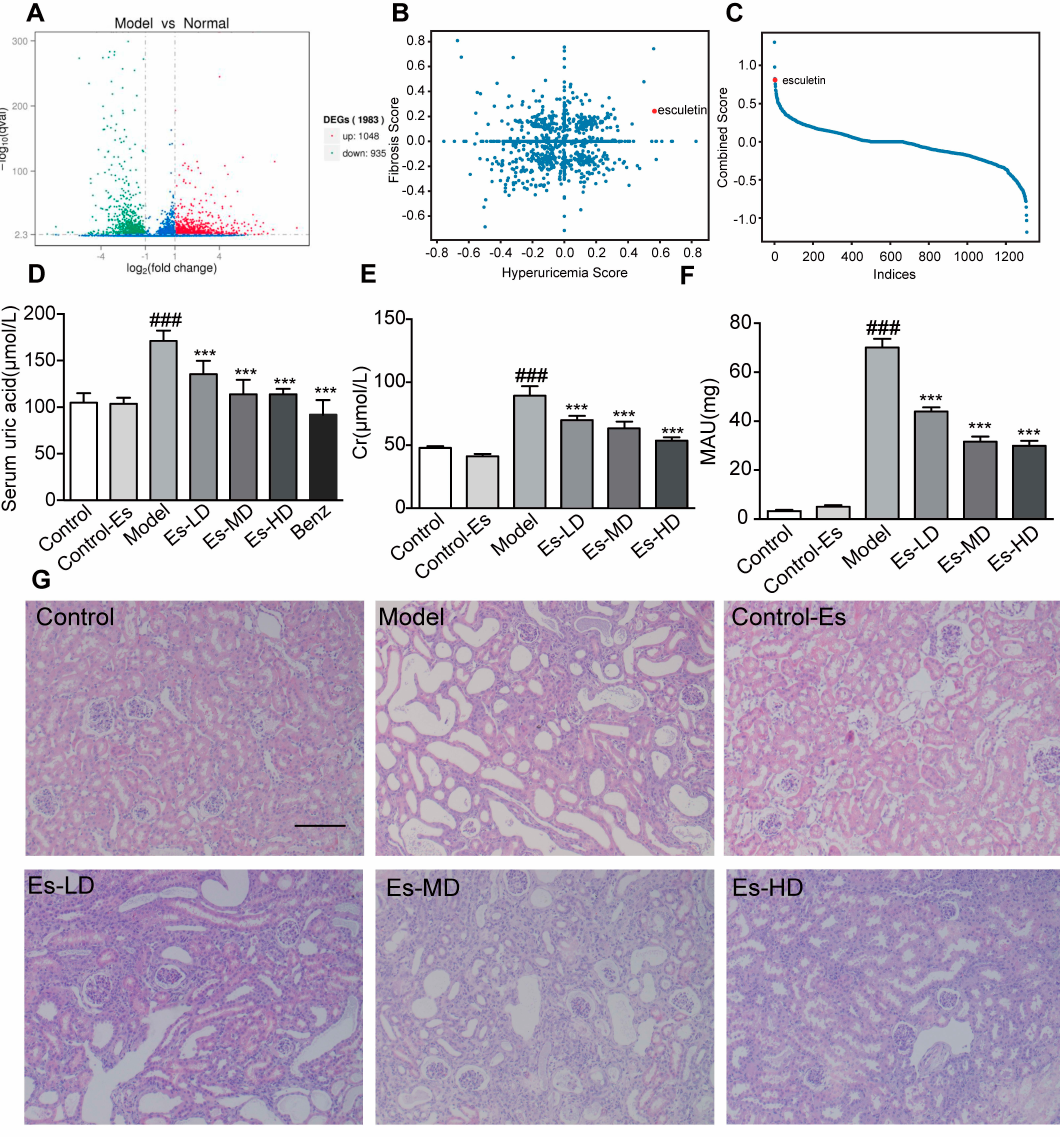
Figure 1. Connectivity map analysis and the e ff ects of Esculetin on HUA with HN. ( A ) Scatter plot of the enrichment scores of HUA and fibrosis. Each dot represents an individual small molecule. Esculetin had a high HUA and positive fibrosis score. ( B ) Sum of the HUA and fibrosis scores. Esculetin had the 4th greatest score amongst the small molecules. X axis: individual small molecules. ( C ) The y -axis is the sum of Hyperuricemia Score and Fibrosis Score. The x -axis is the molecules sorted from high to low according to the Combined Score. ( D ) Serum UA levels in HUA model mice. ( E ) Serum creatinine levels. ( F ) Urine microalbumin. Vertical bars show data with mean ± SD ( n = 6). ### p < 0.001 vs. Control. *** p < 0.001 vs. Model. ( G ) Photomicrographs of HE stained kidney tissues of HUA model mice (magnification 200 ×